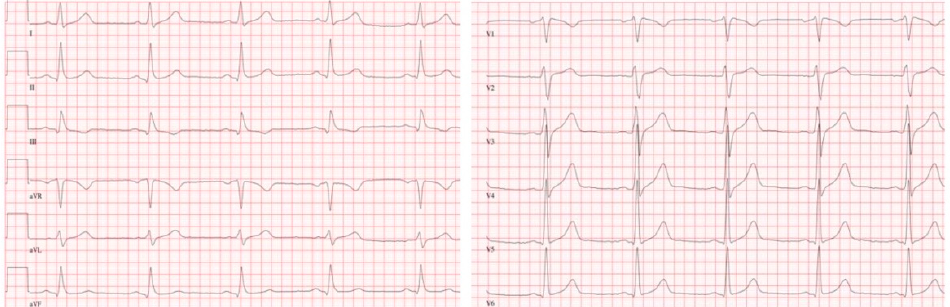
Figure 4. 47 year old male and previously healthy patient with transient Brugada like ECG related to the diagnosis of COVID-19 after recovery. By aggressive antipyretic therapy and supportive peri-infectious therapy the patient recovered within 7 days and the fluctuant Brugada like ECG pattern showed gradual recovery and were in the further ECG recordings not detectable.